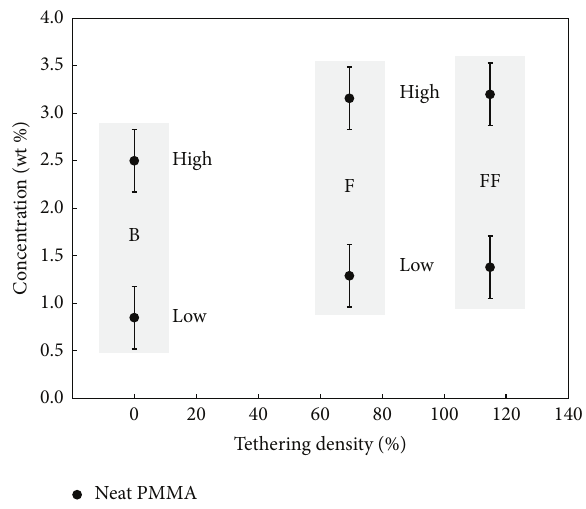
Figure 4: The concentration of the B (bare), F ( ∼ 73% surface coverage) and FF ( > 100% surface coverage) silica nanoparticles in PMMA as measured by TGA. The vertical capped lines through symbols indicate error from TGA